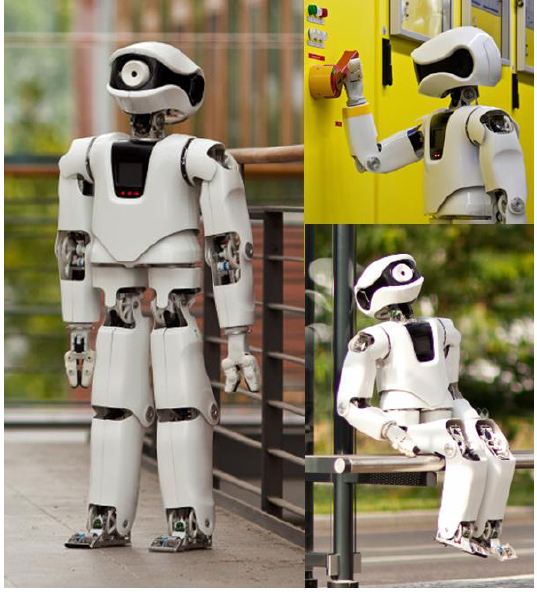
Figure 7: Myon the child-like cognitive robot developed by the Neuro Robotics group at Humboldt university.